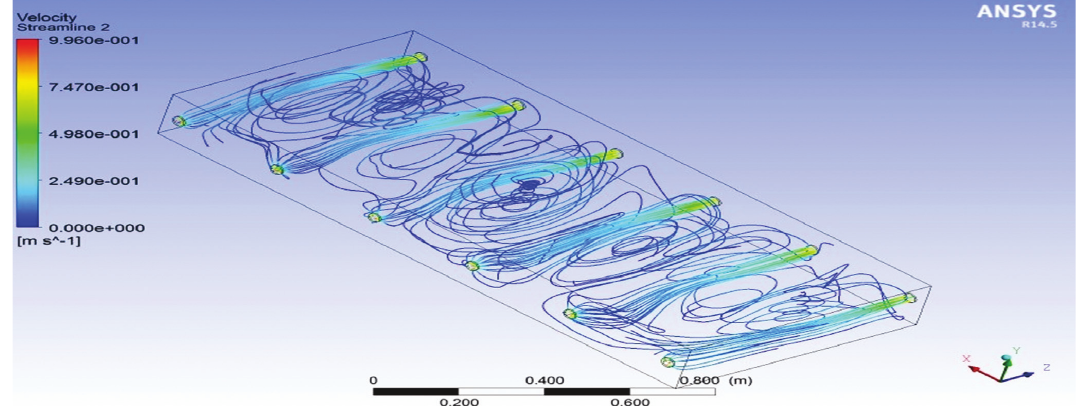
Figure 13: Velocity path lines and the temperature effect in the solar